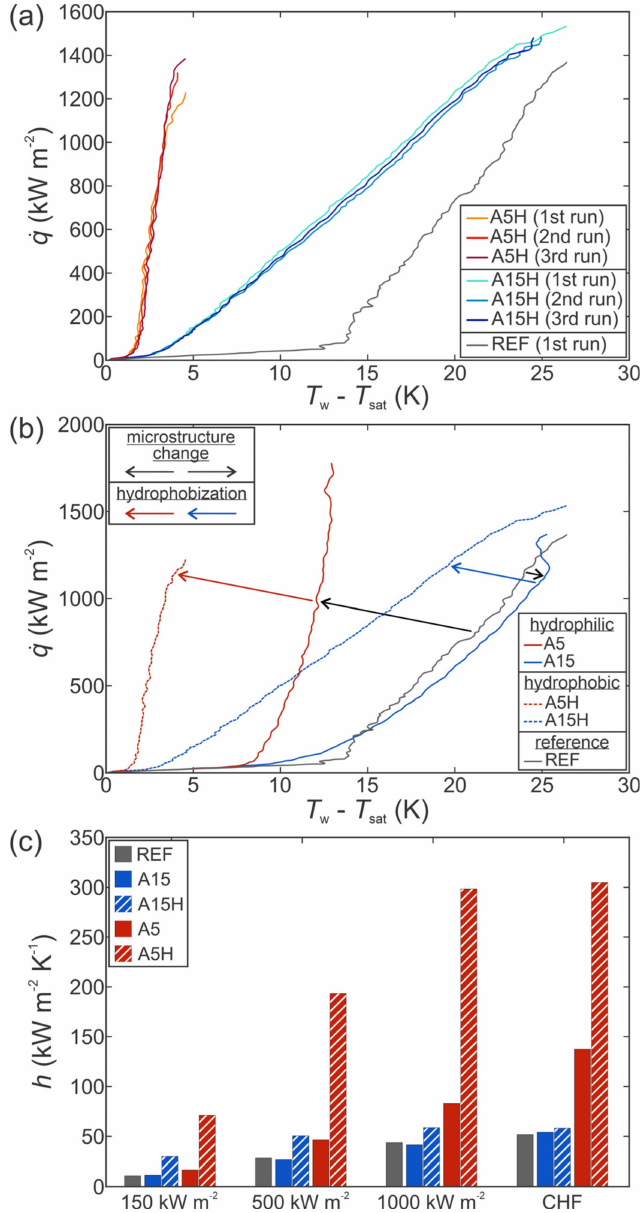
Figure 6. Pure water boiling curves on hydrophobized surfaces A5H and A15H ( a ), comparison of the effect of microstructure change and hydrophobization on boiling performance ( b ) and comparison of the highest heat transfer coefficients recorded during boiling of pure water at selected heat fluxes ( c